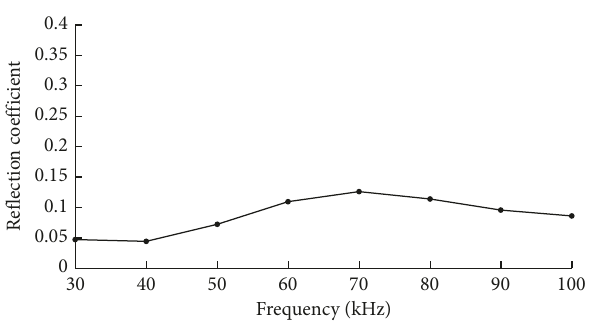
Figure 7: Ratio of the damage signal to first received signal amplitude.